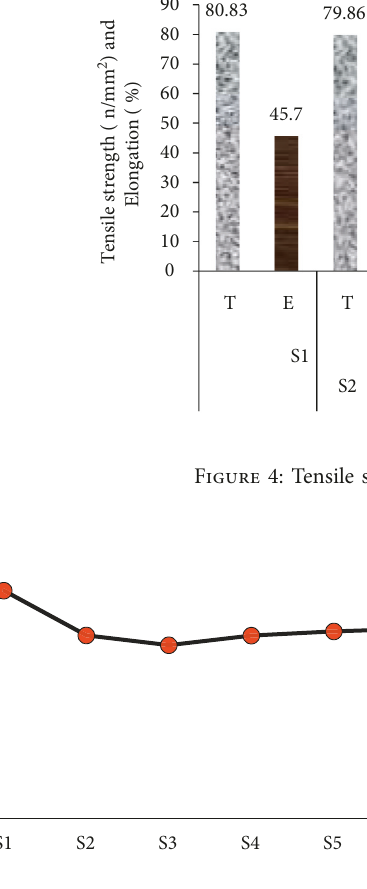
Figure 5: Tear strength value of treated skin samples.